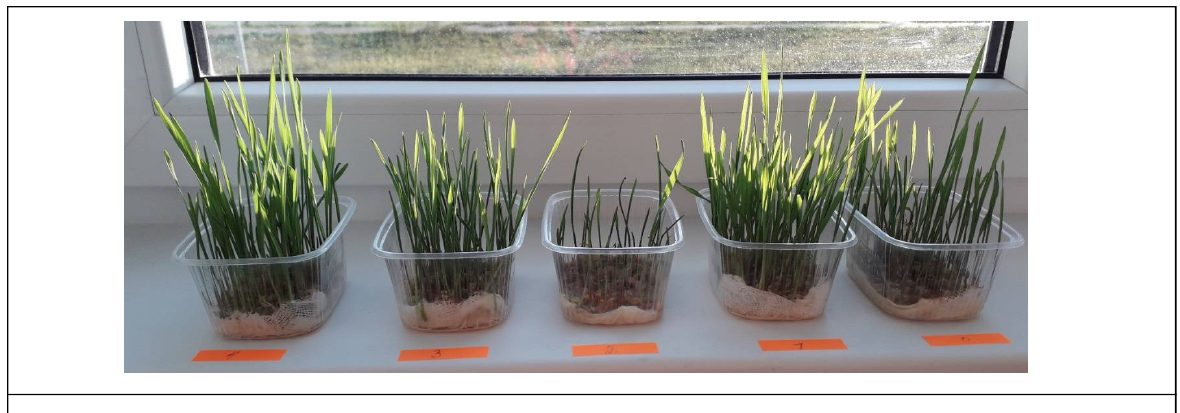
Figure 11: Tríticum durum in ordinary and “saturated” water (August 24, 2019)